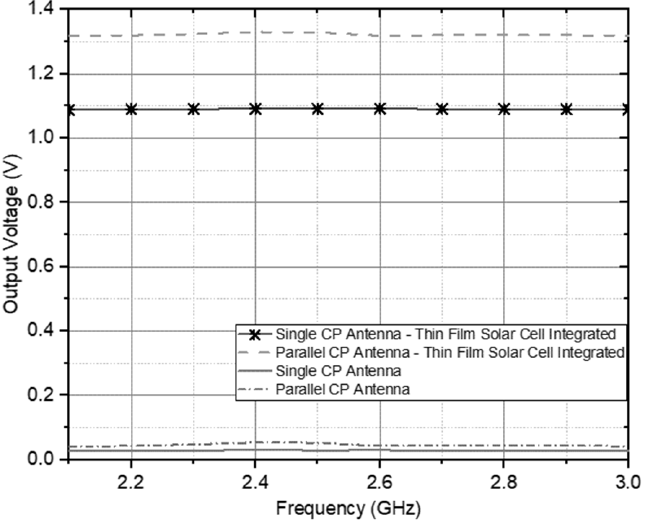
Figure 16. The increased voltage on the integration of the CP Antenna with the 2 × 4 Hybrid Coupler for Hybrid Electromagnetic Solar Energy Harvesting.